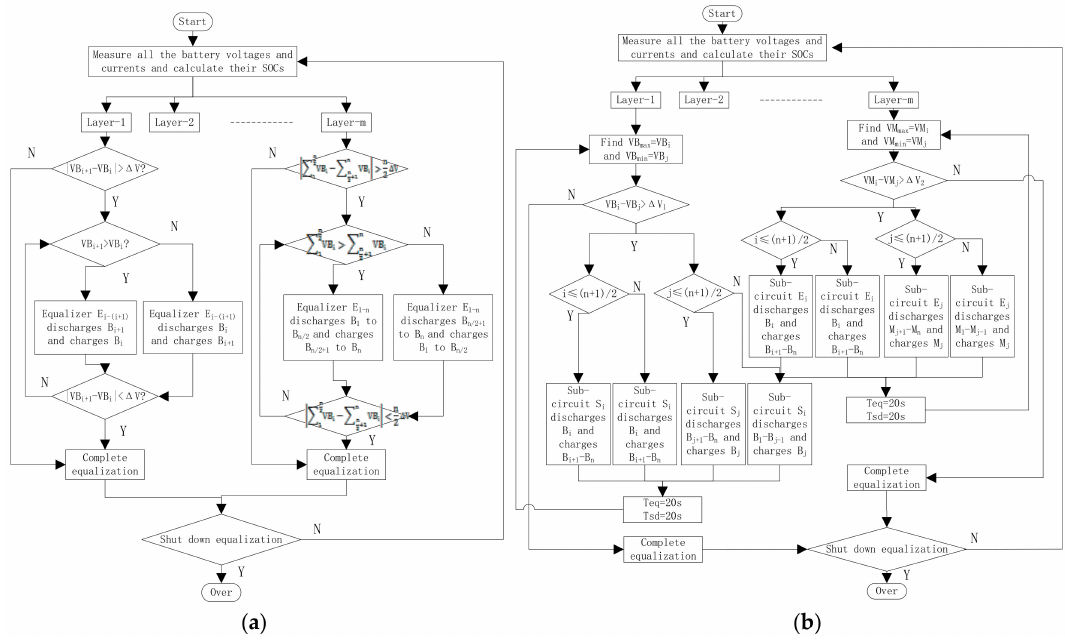
Figure 7. The equalization flow charts of the PAE and the IBLBE. ( a ) The PAE; ( b ) the IBLBE. Table 2. The balancing time in different distribution sequence for PAE and IBLBE (time unit: second).